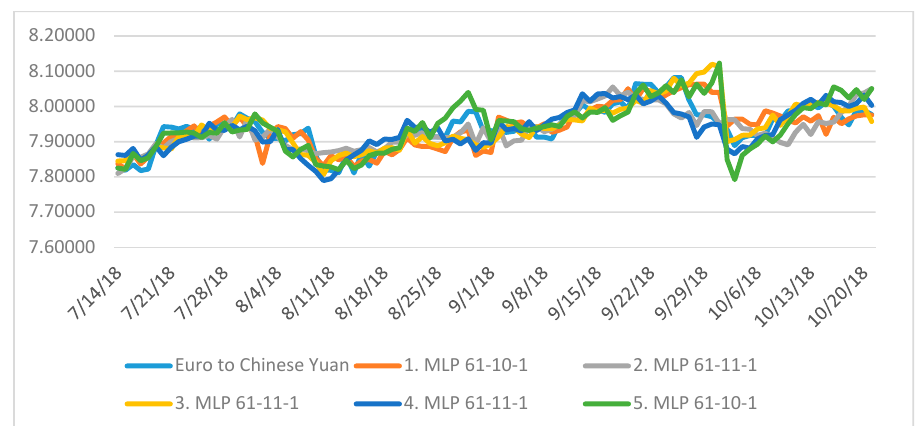
Figure 8. Line graph—development of Euro to Yuan predicted by neural networks compared to actual exchange rate between 14th July and 21st October 2018. (Source: Own processing.) The graph shows that all neural networks can imitate the exchange rate of Euro to Yuan quite well. The deviation in the individual interval sections is 0.05 Yuan at most. Bigger differences were detected only on 25th September 2018, 1st October 2018, and 2nd October 2018; however, even on these days, the differences are not bigger than 0.1 Yuan. Based on the graph comparison, it can be stated that all the retained neural networks are applicable for the prediction. Therefore, examining residuals appears to be interesting. The development of the residuals between 14th July and 21st October 2018 is seen in Figure 9.